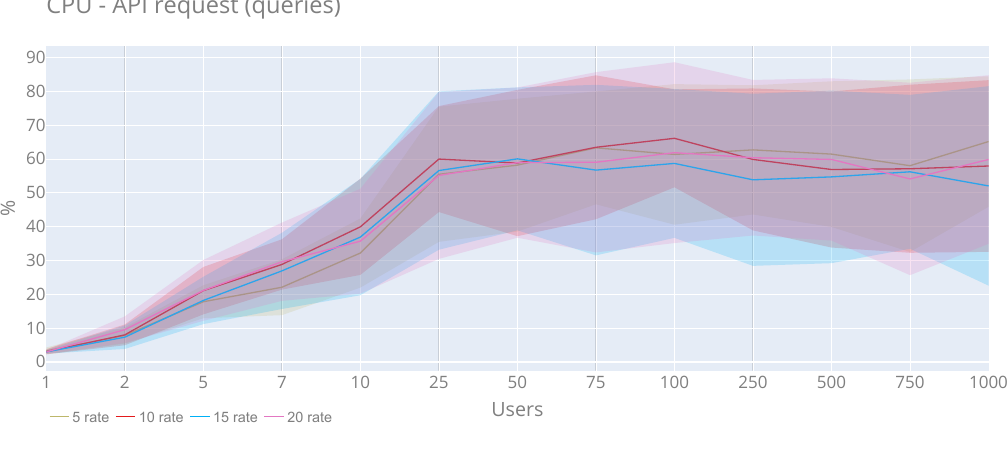
Figure 19. CPU utilisation of the API queries with a rate 5, 10, 15 and 20 requests per second.